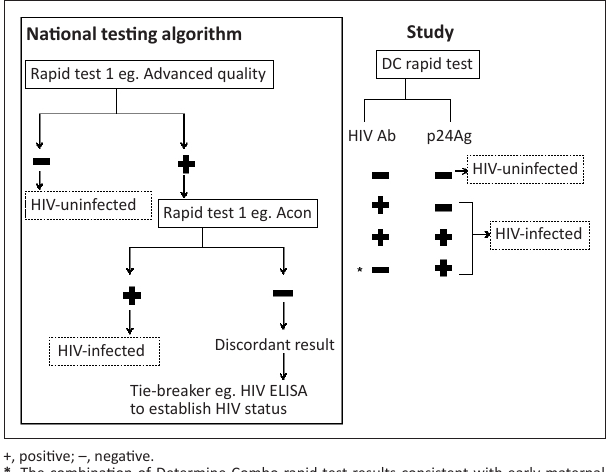
FIGURE 1: Study methodology: The Determine Combo rapid test (DC RT) was performed at the same time as the routine